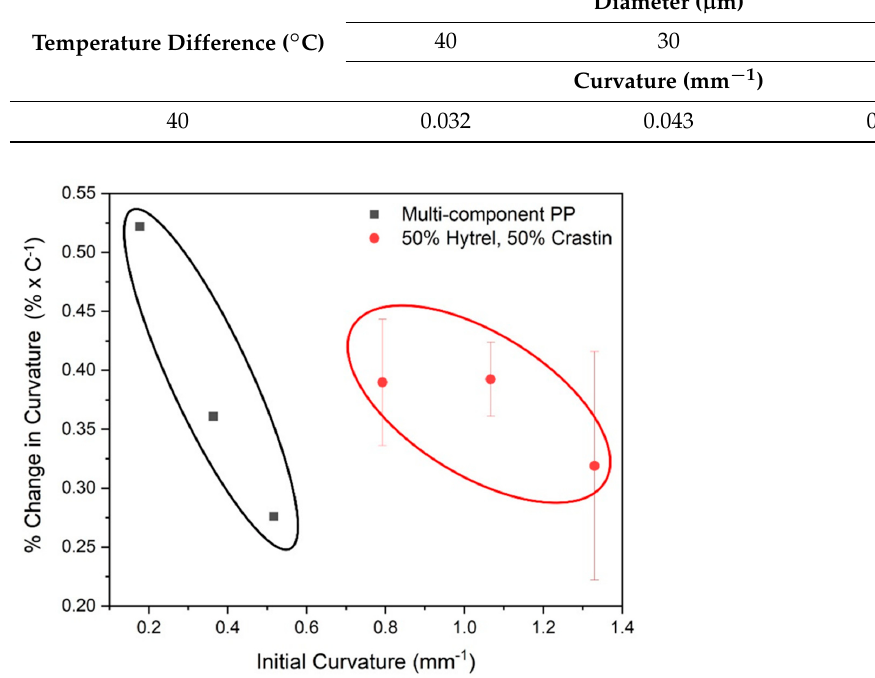
Figure 9. Percent change in curvature with respect to temperature vs. initial fiber curvature for multi-component polypropylene fibers and bicomponent PBT fibers.